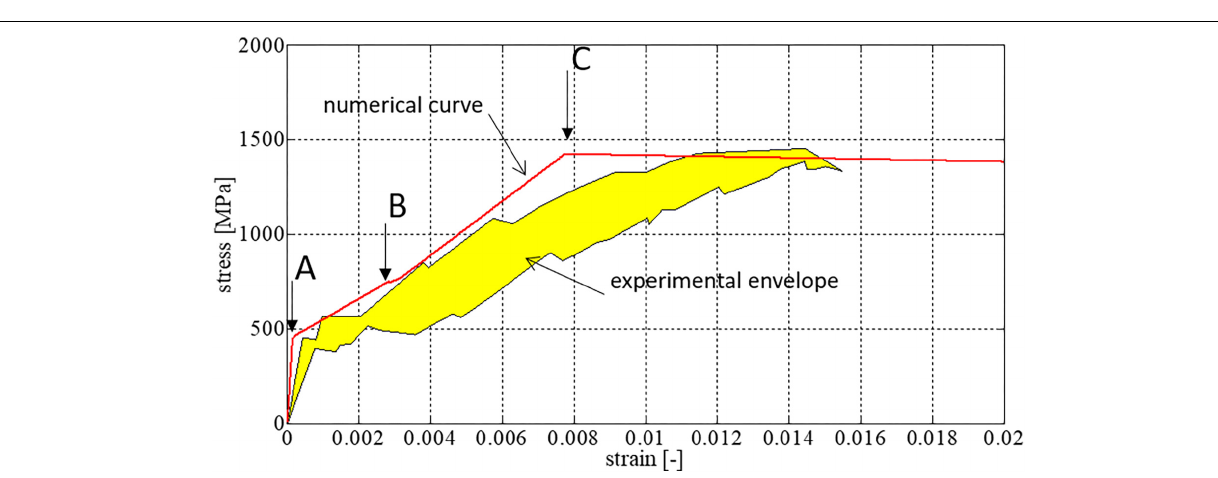
FIGURE 6 | Comparison between numerical and experimental stress-strain curves: clevis case.